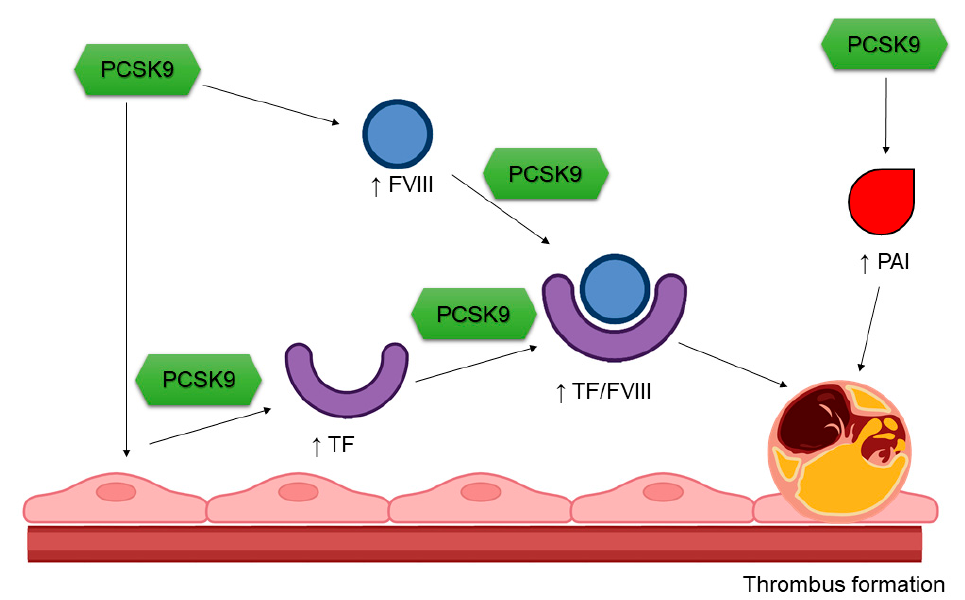
Figure 3. Influence of PCSK9 on coagulation and fibrinolysis. PCSK9 increases the release of TF from the endothelial cells, activates the extrinsic pathway of coagulation, increases the concentration of FVIII and, thus, increases the TF/FVIII complex. On the other hand, it increases the release of PAI-1 and reduces fibrinolytic capacity. PCSK9—proprotein convertase subtilisin/kexin type 9, TF—tissue factor, FVIII—factor VIII, PAI-1—plasminogen activator inhibitor-1.